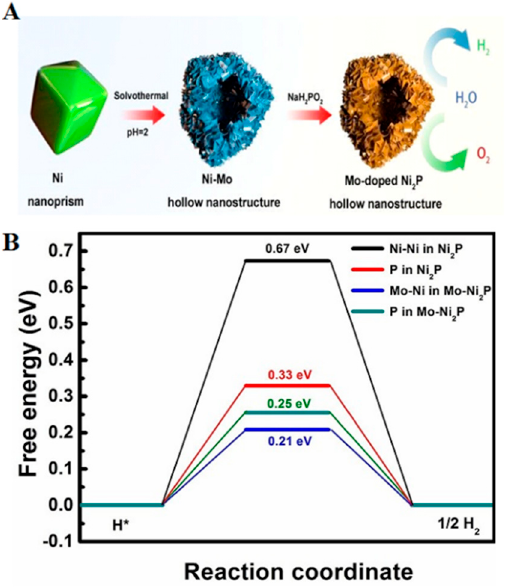
Figure 4. ( A ) Schematic illustration of the synthesis of Mo-doped Ni 2 P hollow nanostructures. ( B ) Free energy diagram for HER on Ni-Ni site in Ni 2 P, P site in Ni 2 P, Mo-Ni site in Mo-Ni 2 P and P site